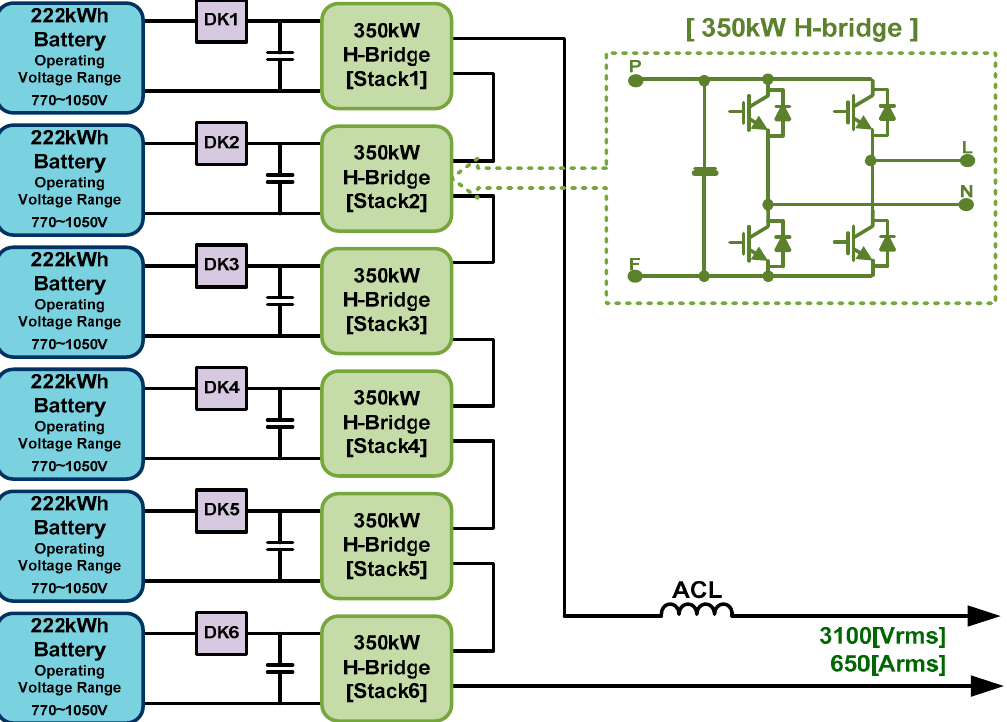
Figure 5. Circuit diagram of single-phase 13-level MMC power conditioning system (PCS).